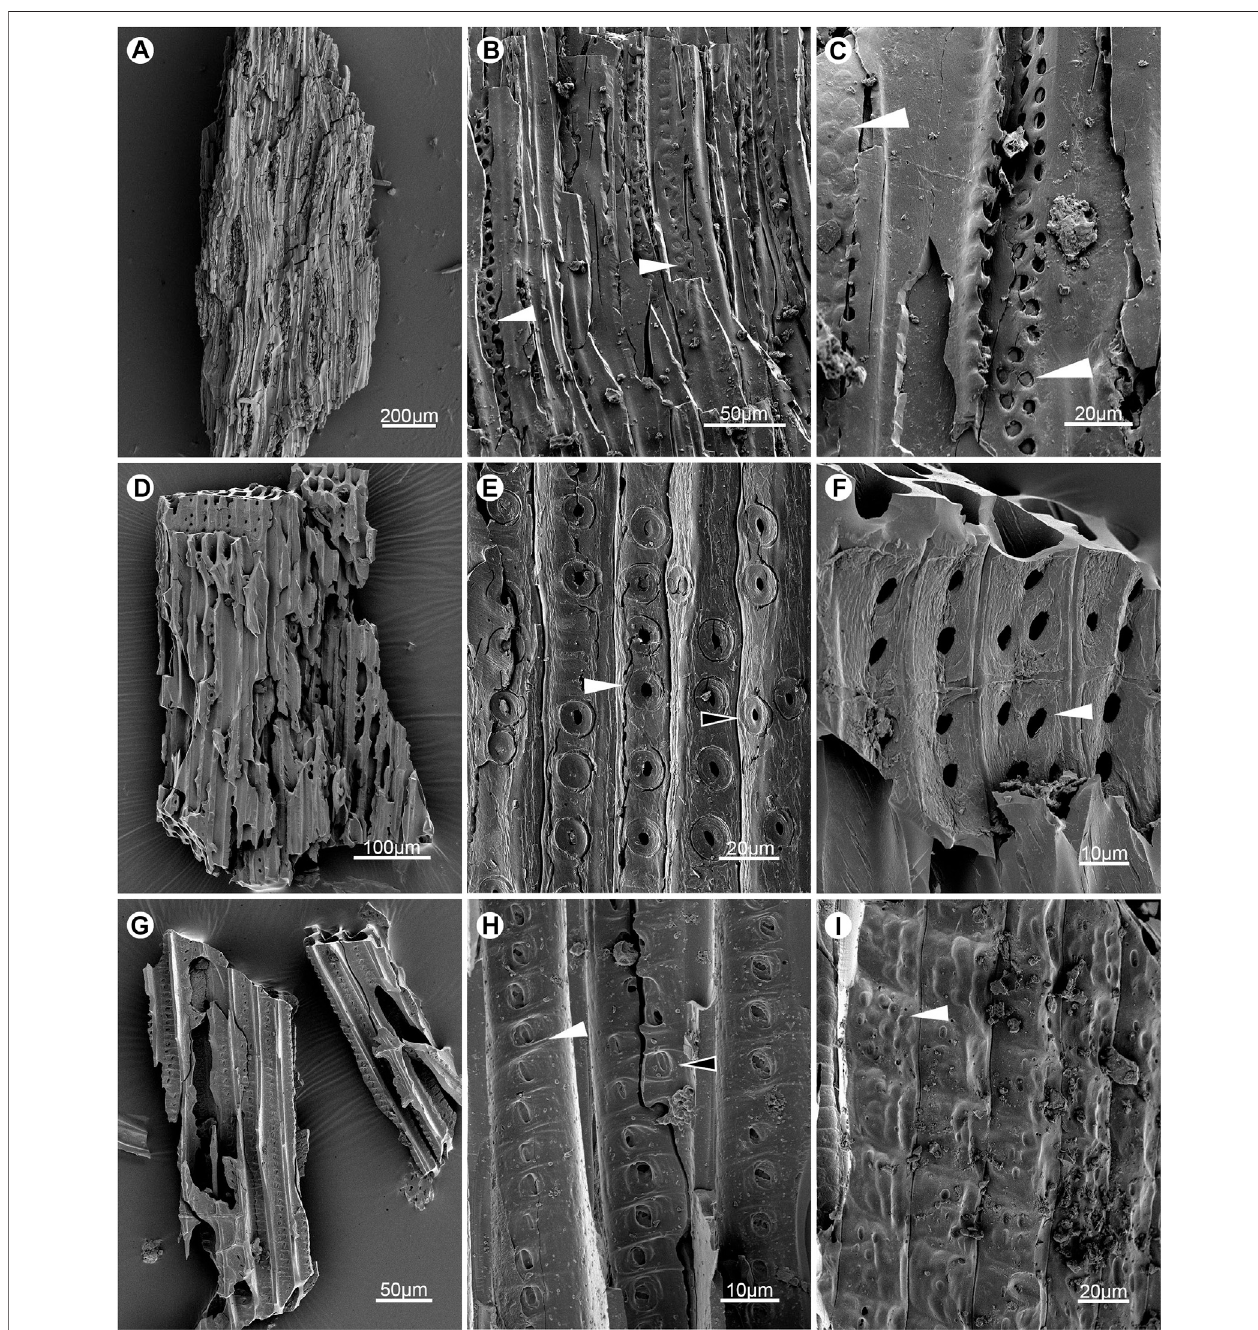
FIGURE 4 | SEM images of charcoal Type 5 (A – C) , Type 6 (D – F) and Type 7 (G – I) from the Lengqinggou section in Guizhou Province, Southwest China. (A) Tangentialview,showingthecommon occurrences ofrays. (B) Oblique radialviewoftracheids, showing uni-andbiseriatebordered pitsontheradialwalls(arrows).